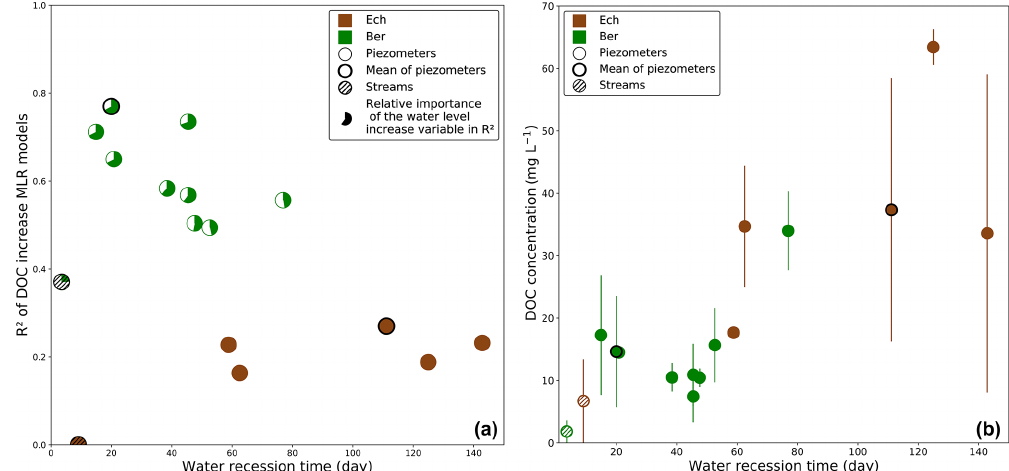
Figure 5. Relationship between water recession time coefficients and (a) the R 2 of the DOC_increase MLR models or (b) the DOC con- centration of each water level monitoring plot at the peatland of Bernadouze (green) or Ech (brown). In both graphs, piezometer plots are represented by solid circles while the mean of the piezometers at each site is surrounded in black. Stream plots correspond to the two black striped circles in each graph. In graph (a) , pie charts represent the relative importance of the water level increase variable in the R 2 of each model. In graph (b) , a marker represents the mean DOC concentration of a plot and vertical segments the standard